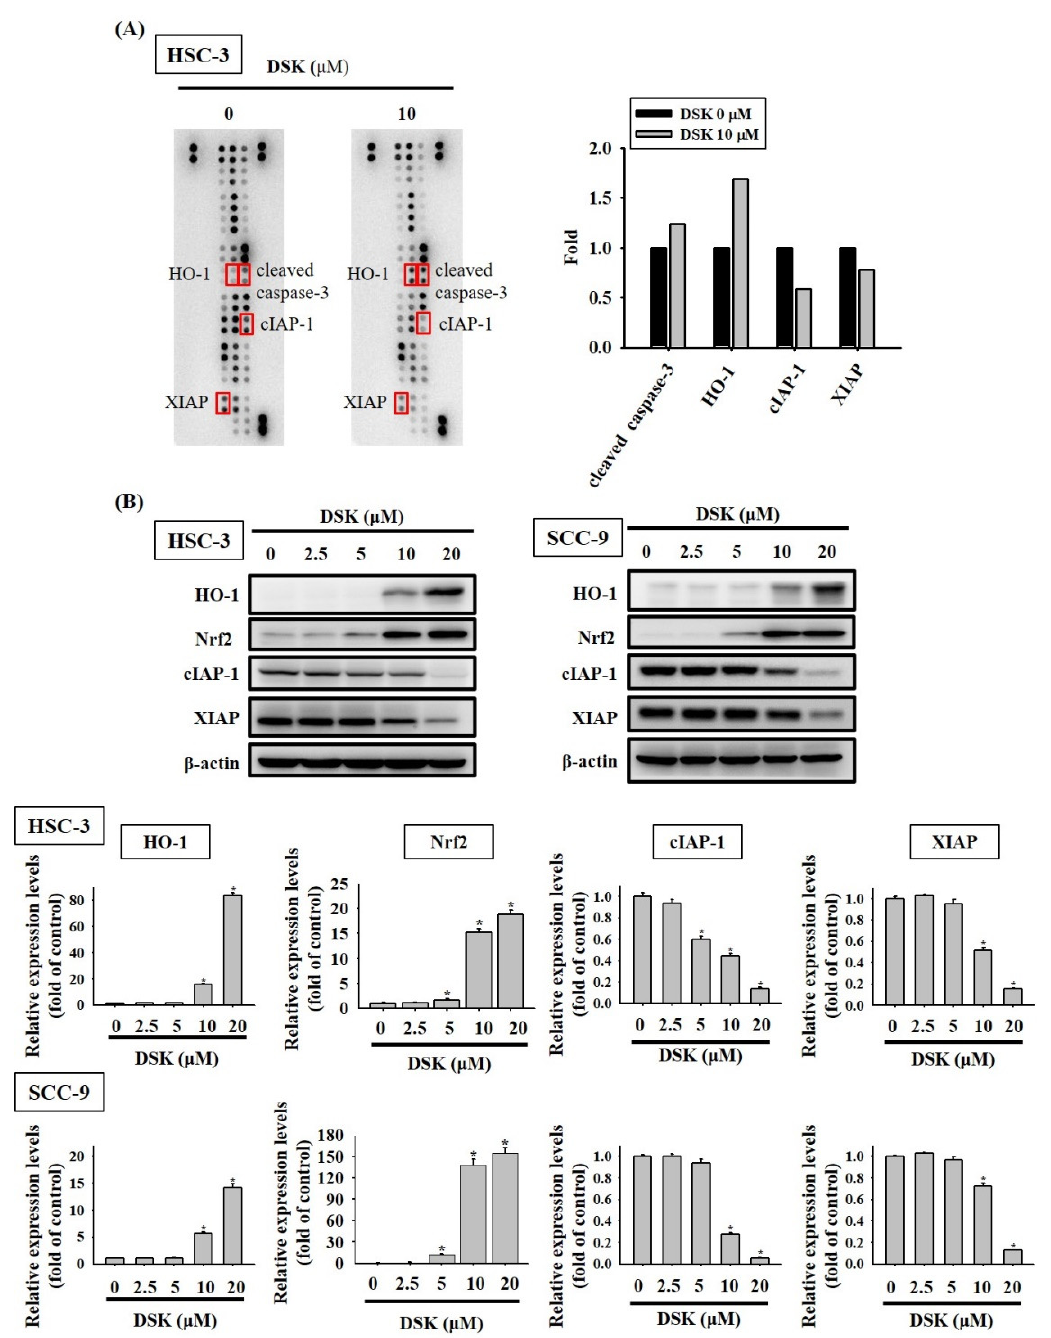
Figure 4. Profiling of DSK-induced apoptotic proteome in tongue cancer. ( A ) Representative images of array membranes corresponding to DSK-untreated and -treated protein expression in HSC-3 cells. Differentially expressed proteins are labeled and selected for further verification. ( B ) HSC-3 and SCC-9 cells were treated with various concentrations of DSK for 24 h and assessed for the expression of indicated apoptosis related proteins by immunoblotting. Densitometric analyses were quantified and normalized with internal controls ( β -actin). The values represent the mean ± SD of three independent experiments. * p < 0.05 compared with untreated controls using Student’s t -test.